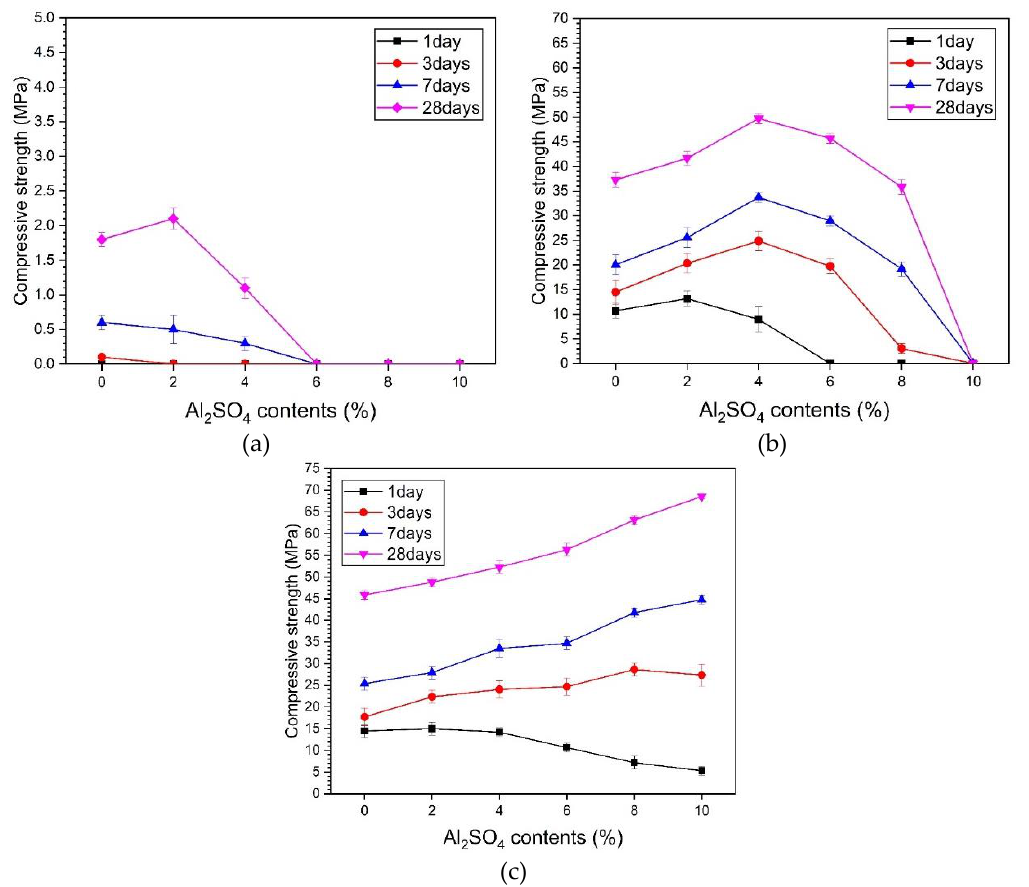
Figure 2. Compressive strength: ( a ) ALS (without alkali), ( b ) 5% alkali with ALS, and ( c ) 10% alkali with ALS.